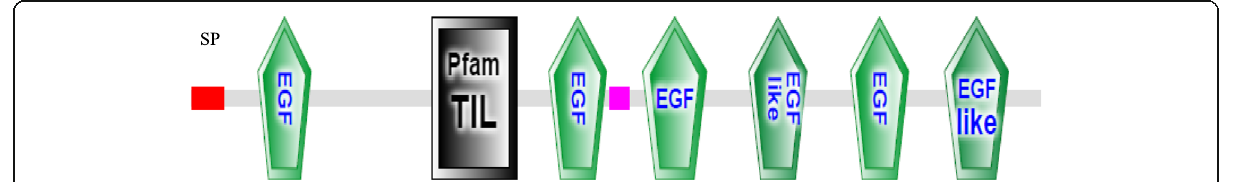
Fig. 3 SMART analysis of the Sra -TIL protein sequence predicted six EGF domains and a TIL domain. A signal peptide, for secretion, was detected by the SignalP v4.0 program at position 1 – 20. Only one low compositional complexity was detected by the SEG program at position 268 –